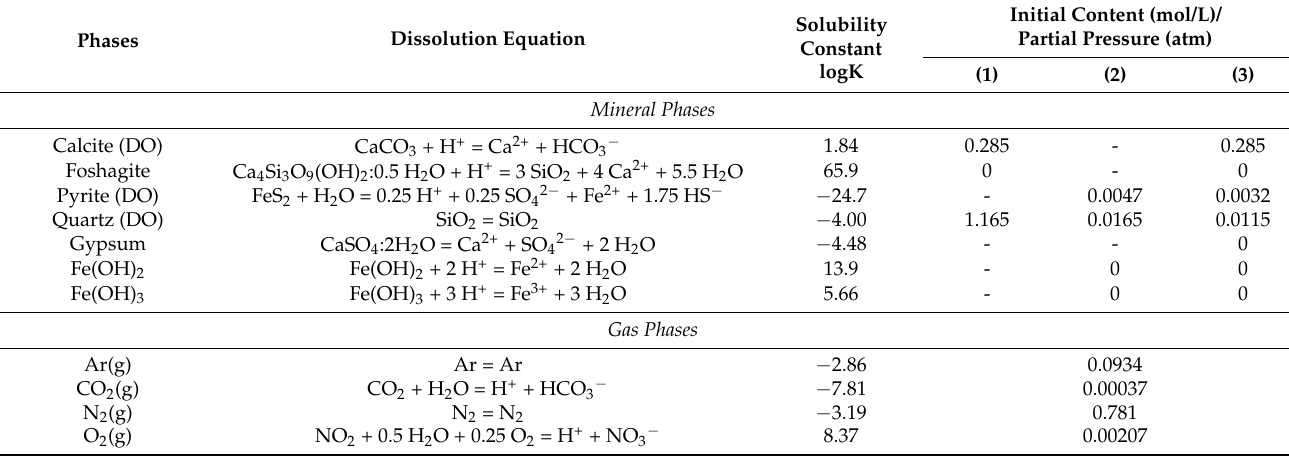
Figure 3. Impact of calcite on pyrite dissolution; arrows indicate the direction of addition or depletion of protons; the vertical line indicates the point of equilibrium with pure water (natural pH). Table 2. Mineral and gas contents of three synthetic matrices: (1) calcite/SiO 2 , (2) pyrite/SiO 2 , and (3) calcite/pyrite/SiO 2 ; other tabulated minerals are expected to form and take part in transitional